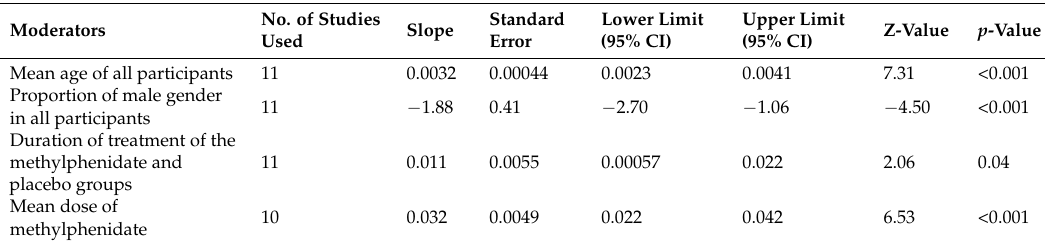
Figure 2. Forest plot and subgroup analysis on post- versus pre-treatment heart rate (HR) between placebo and methylphenidate groups. Table 2. Meta-regression analysis that explored the source of heterogeneity on the post- versus pre-treatment HR between placebo and methylphenidate